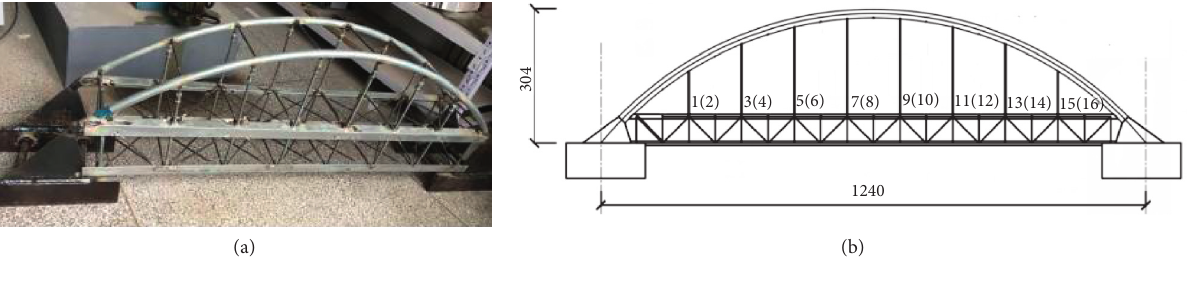
Figure 4: Picture of steel arch bridge model structures.